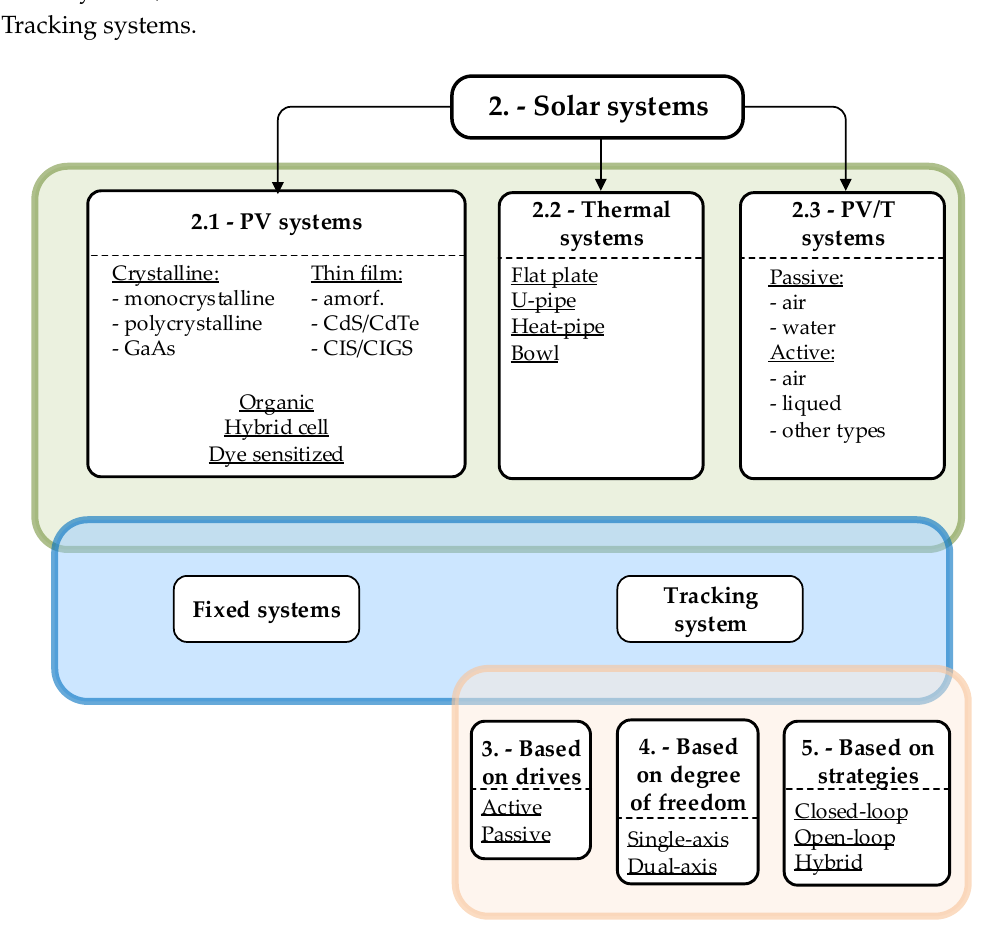
Figure 1. Classification of solar systems.